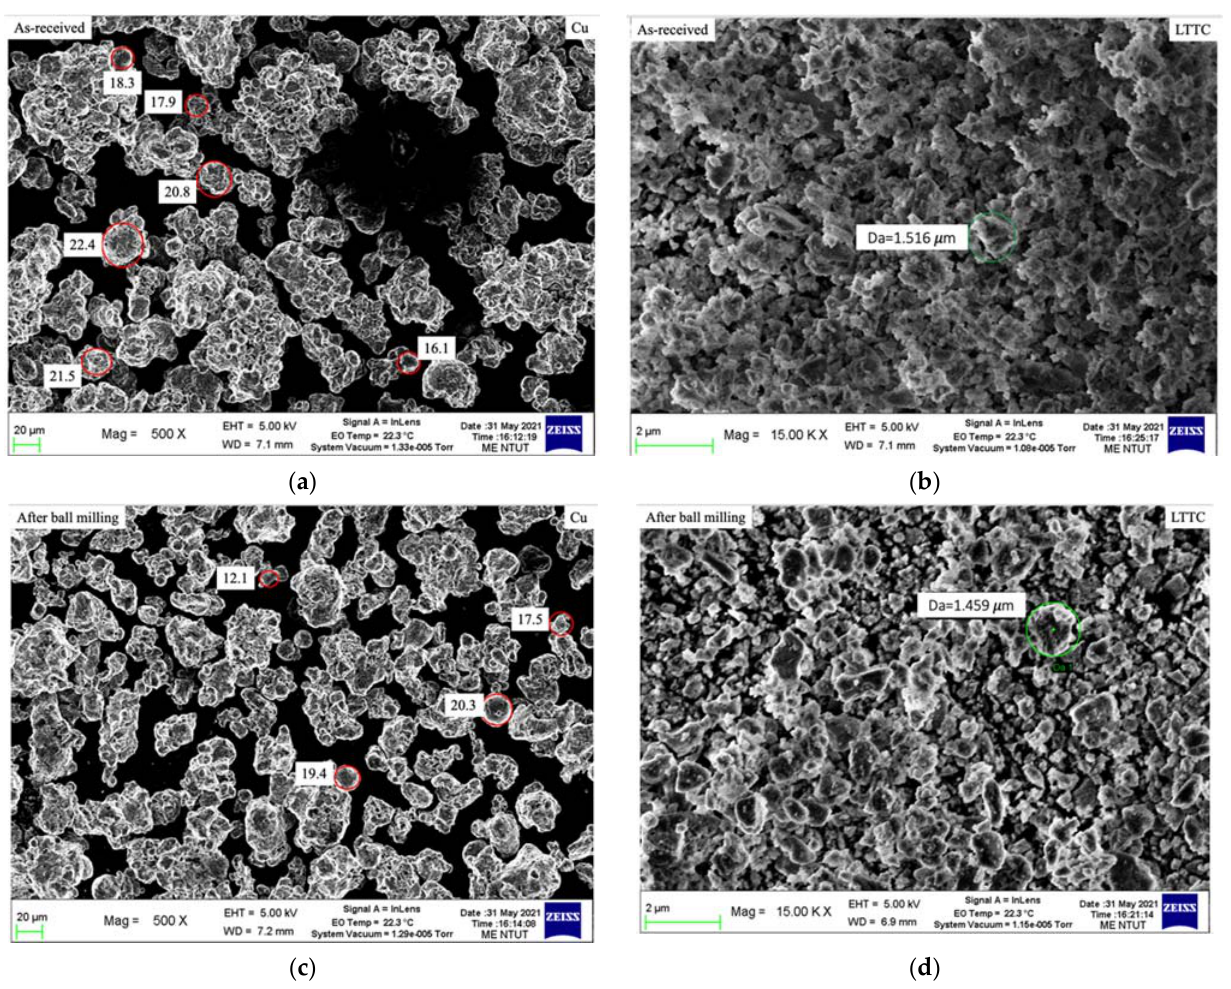
Figure 4. SEM images of LTCC and copper powder for as ‐ received and after ball milling: ( a ) as ‐ received of LTTC; ( b ) as ‐ received of Cu; ( c ) after ball milling of LTTC; ( d ) after ball milling of